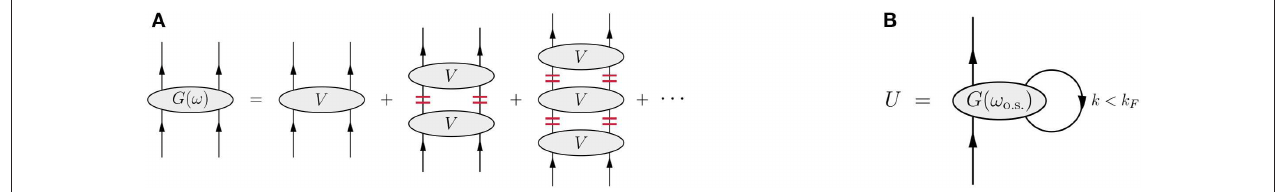
FIGURE 16 | Graphical representation of the determination of the single-particle potential from the G-matrix interaction (B) and of the Bethe-Goldstone equation (A) . The symbol ω o.s denotes the on-shell starting